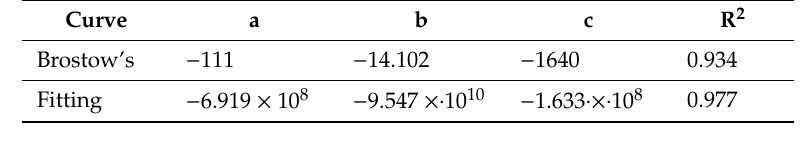
Table 5. Fitting coe ffi cients proposed by Brostow and calculated for the obtained data.